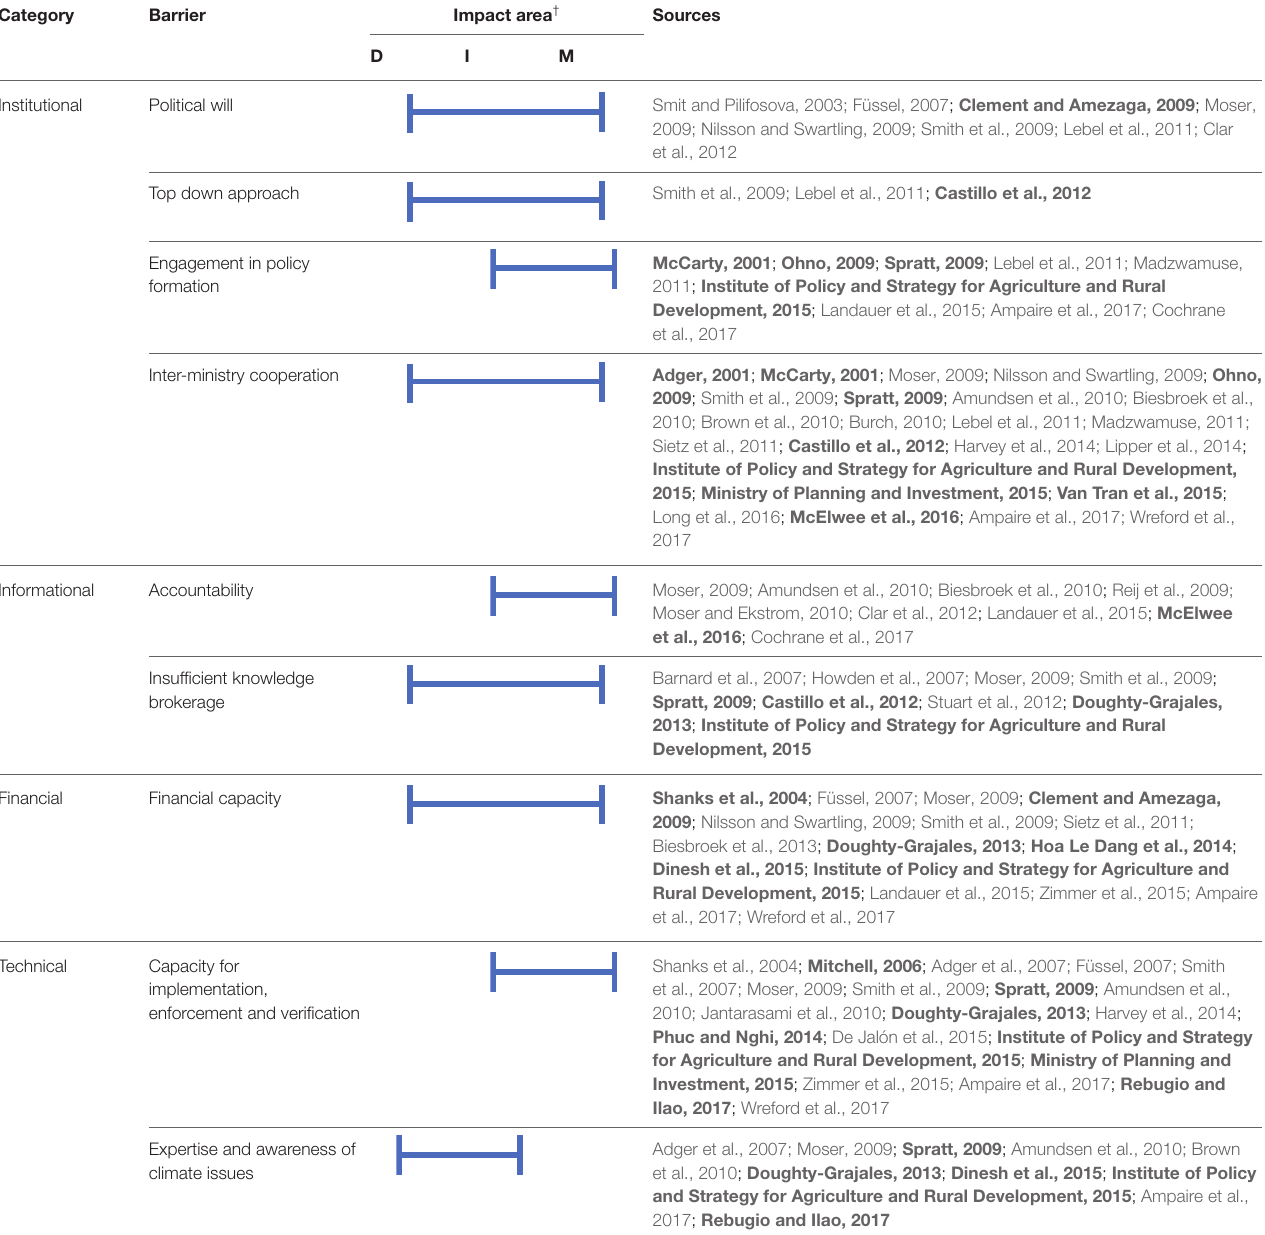
TABLE 1 | Barriers identified in the literature and the stages of the policy process that they